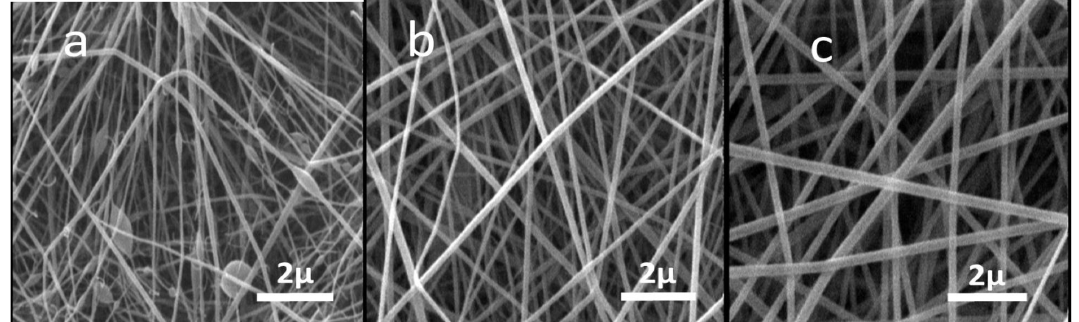
Fig. 5. Morphology of PAN nanofibers electrospun at different applied voltage. The polymer solutions were electrospun at 15 (a), 20 (b) and 25 kV (c) applied voltage, the polymer concentration and nozzle to collector distance were 7.0 wt.% and 10 cm